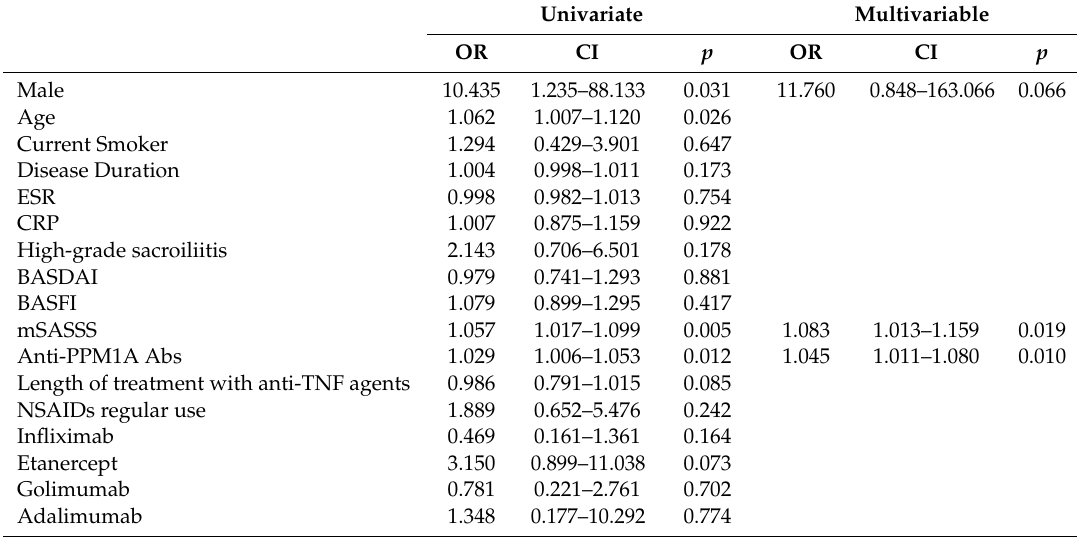
Table 2. Factors associated with radiographic progression in AS patients treated with anti-TNF agents.